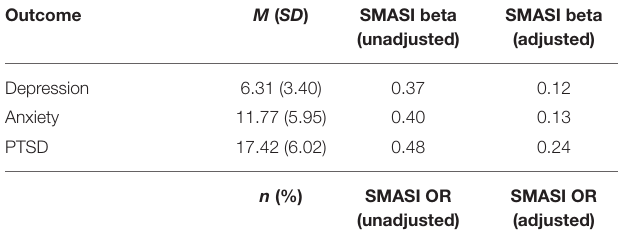
TABLE 4 | Health outcomes and associations with minority stress (SMASI), with and without adjusting for general stress (PSS). Outcome M ( SD ) SMASI beta Depression 6.31 (3.40) 0.37 0.12